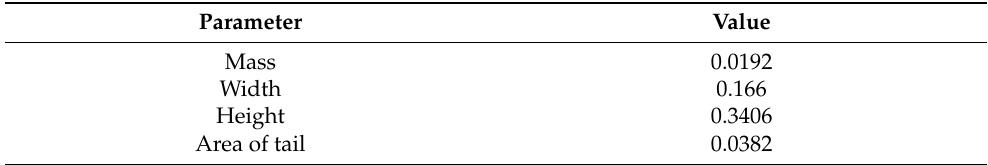
Figure 2. The reconstruction of the swimmer model and kinematics. ( a ) Fish prototype. ( b ) Fish model. ( c ) Midline extracted by Tytell et al. from video recordings of the bluegill sunfish escape process. ( d ) Keeping the front part horizontal and fixing the COM at the origin. ( e ) Midline kinematic inputs that satisfy conservation of linear momentum and angular momentum. Table 1. Dimensionless parameters of the crucian carp